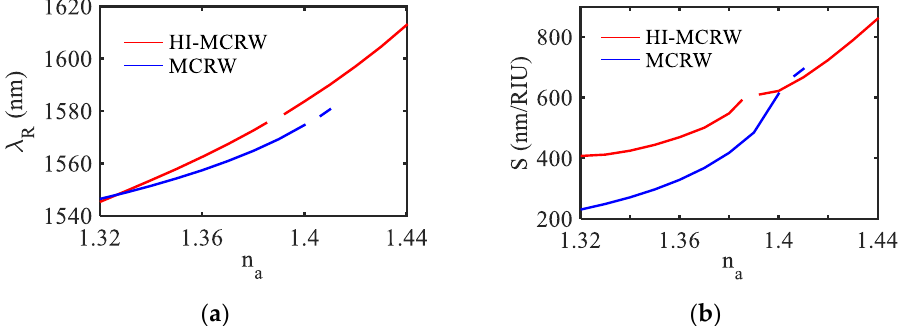
Figure 8. ( a ) Variation of resonance wavelength and ( b ) corresponding RI sensitivity with ambient RI for the TE 00 mode.